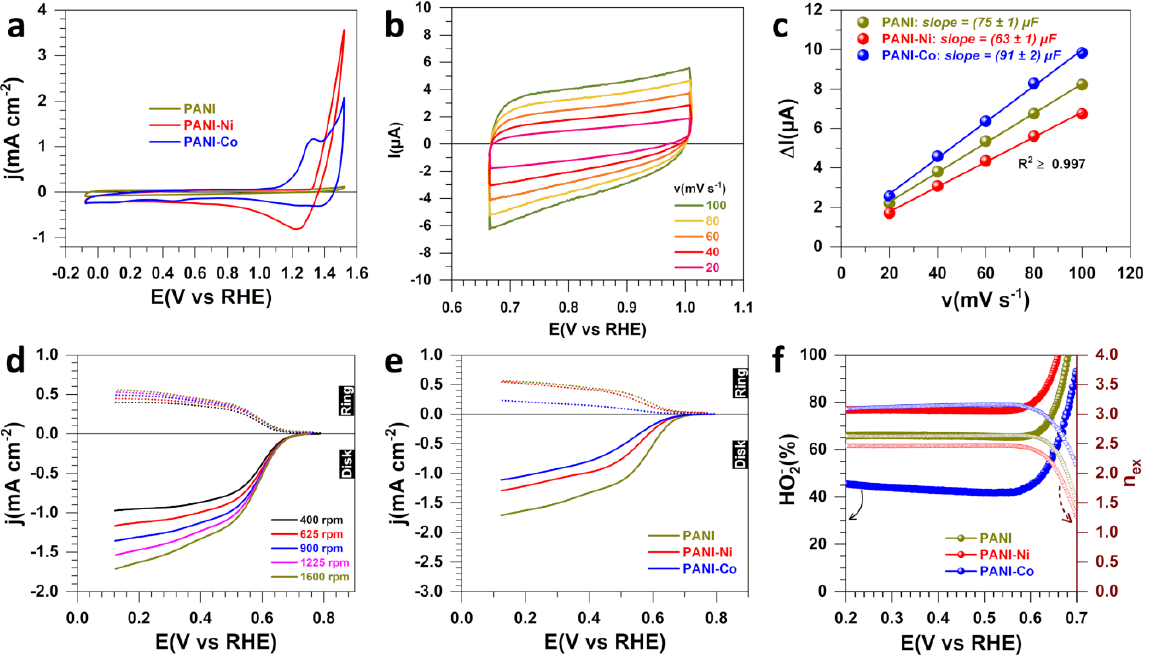
Figure 1. Electrochemical characterization for the materials obtained after polymerization (5 ◦ C, 13 h). ( a ) iR-drop uncorrected CV (N 2 -saturated 1 M KOH, 25 ◦ C, 100 mV s − 1 , 0 rpm). ( b ) iR- drop uncorrected CV of PANI-Ni (N 2 -saturated 1 M KOH, 25 ◦ C, 0 rpm) for determining ECSA. ( c ) Capacitive current ( ∆ I a = I a − I c ) vs. scan rate at E(V RHE ) = 0.8 (PANI), 1.0 (PANI-Ni) and 0.8 (PANI-Co). ( d ) iR-drop uncorrected LSV of ORR for PANI at different speeds of RRDE (O 2 -saturated 1 M KOH, 25 ◦ C, 5 mV s − 1 , E ring = 1.2 V RHE ). ( e ) iR-drop uncorrected LSV of ORR at RRDE (O 2 -saturated 1 M KOH, 25 ◦ C, 5 mV s − 1 , 1600 rpm, E ring = 1.2 V RHE ). ( f ) HO 2 − % (left) and number of transferred electrons per molecule of O 2 (right y -axis) from panel ( e